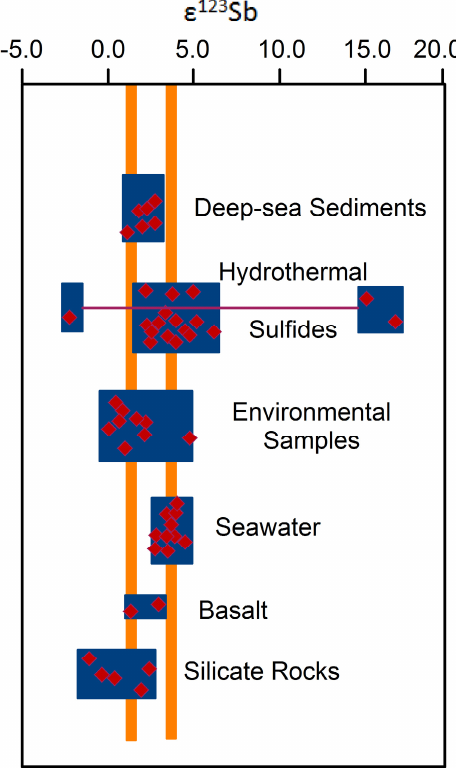
Figure 15. Summary of ε 123 Sb values measured in various natural materials. Variations indicate that Sb isotopes may be used as a contaminant tracer in geological media (from Rouxel et al.